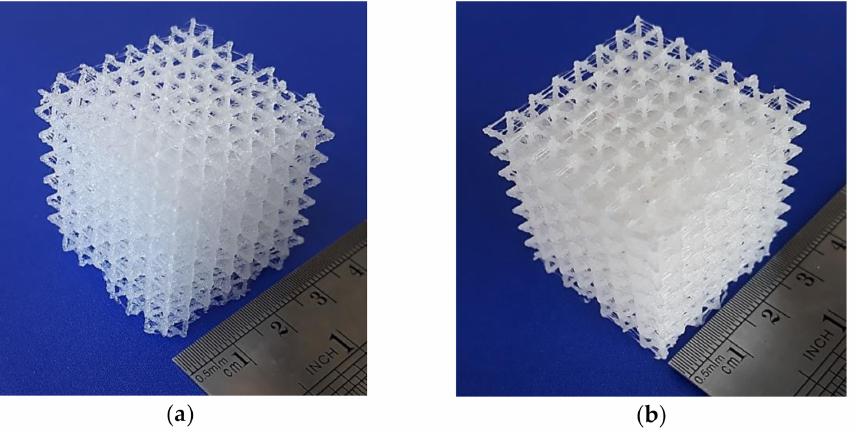
Figure 15. 3D printed lattice structures (scale 1:1, Up mini 2): ( a ) CVC printed using PLA; ( b ) CVC printed in